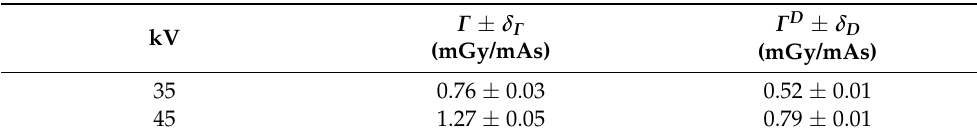
Table 2. Total air kerma per mAs ( Γ ) and total air dose per mAs ( Γ D ) performances of the Apogee X-ray tube at isocenter.